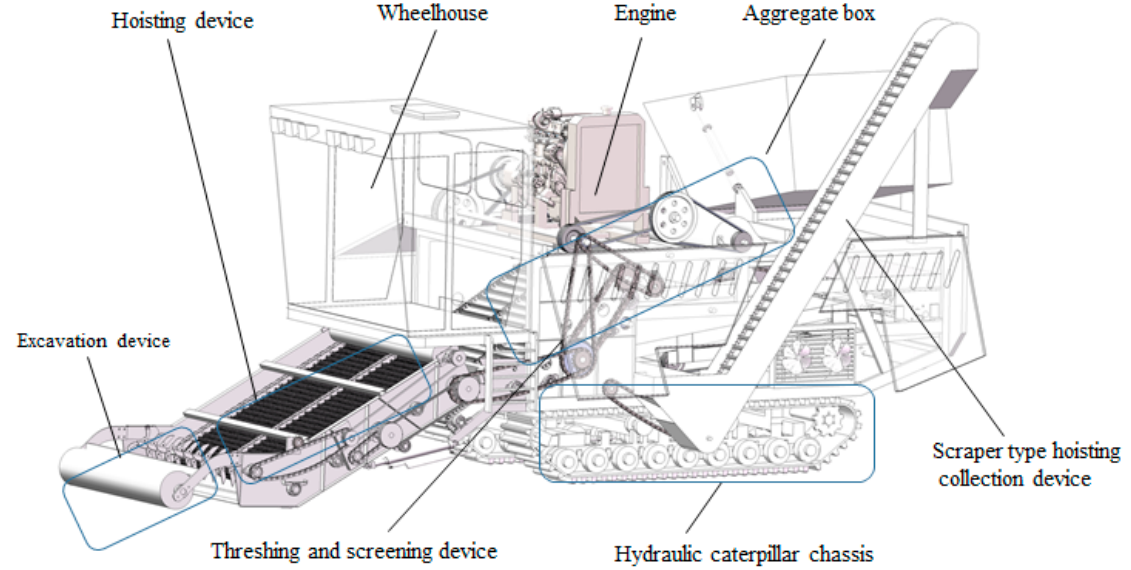
Figure 1. Overall structure of CSTH.